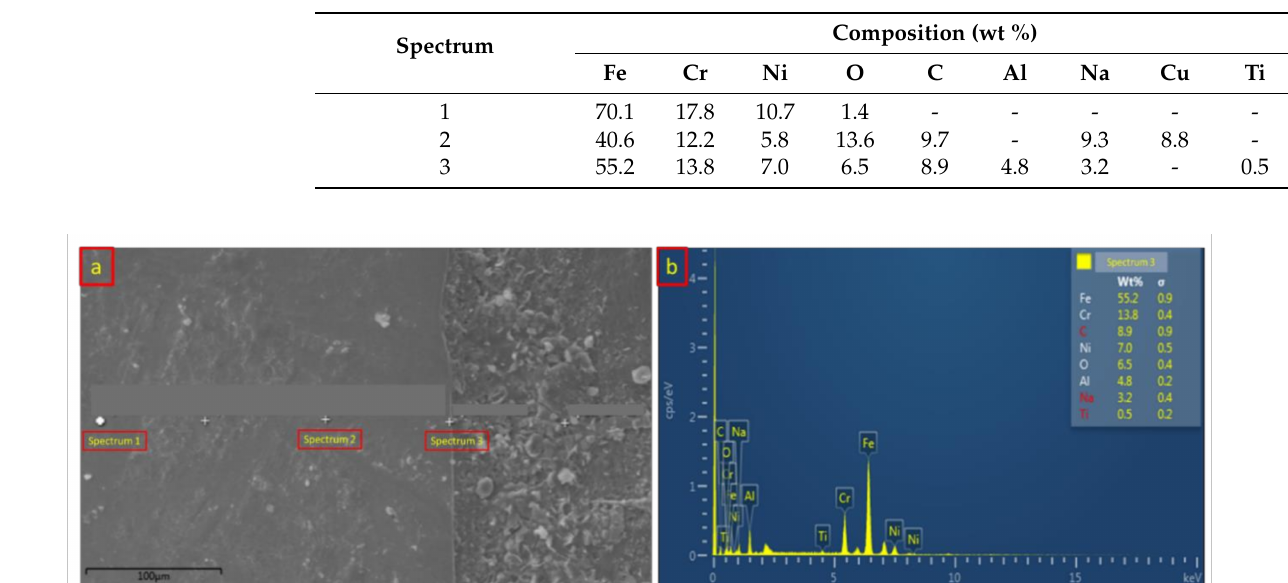
Figure 10. ( a ) SS/Al spectrum distribution of the EDX analysis from sample 1; ( b ) SS/Al EDX analysis result on the IMC layer from sample 1.